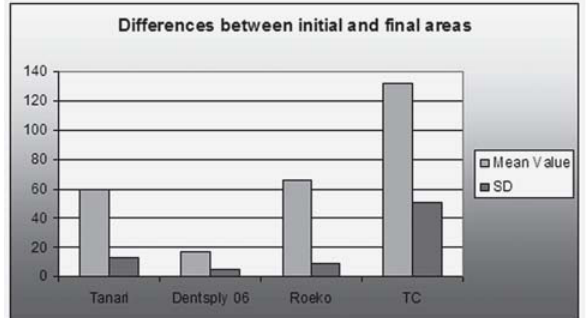
FIGURE 1- Means and standard deviations for the differences between initial and final areas of the experimental